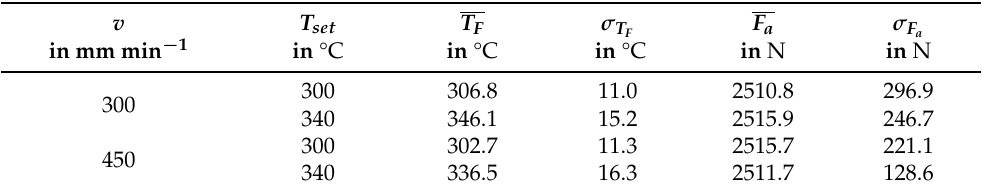
Table 6. Average temperature T F in °C and average axial force F a of the transfer tests with the material combination PPS-CF with EN